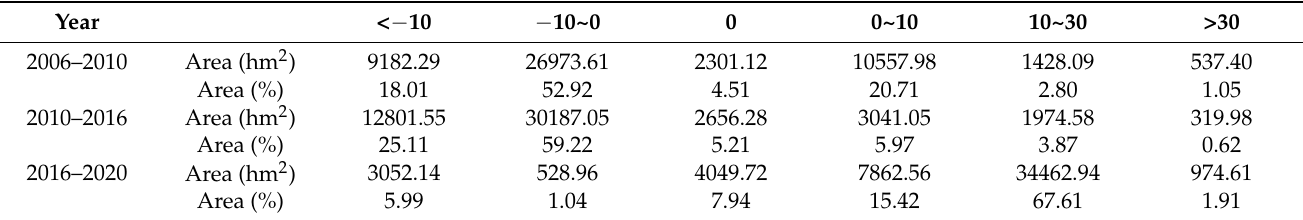
Table 1. Area distribution of variation range of different NPP (gC/(m 2 · month)).